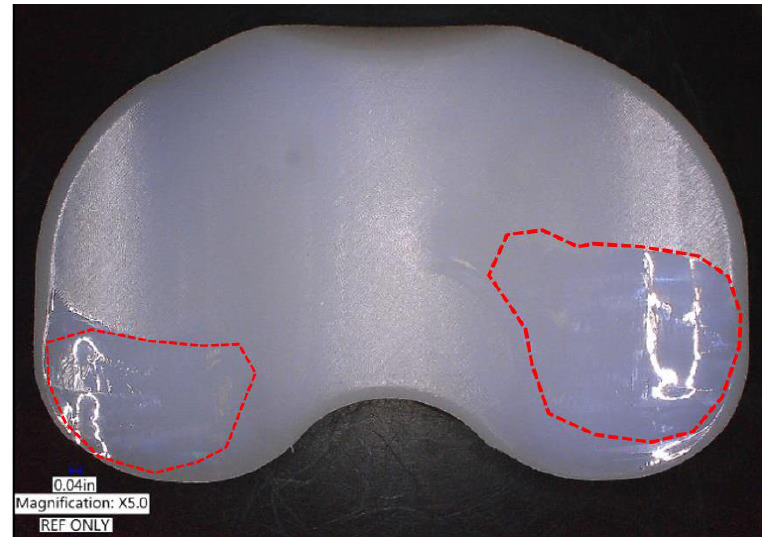
Figure 9. Experimental wear contour of optimal model after 5 million cycles.